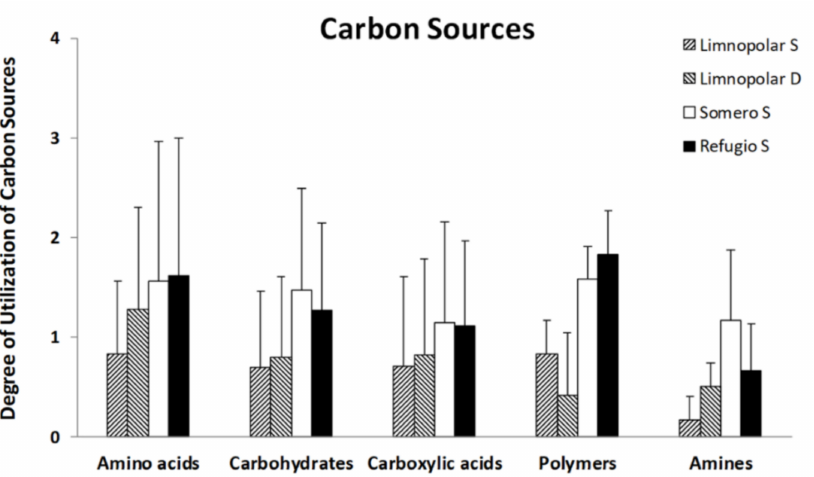
Figure 4. Average utilization values for the different carbon source groups (Biolog Ecoplates) by the microbial community of the Lake Limnopolar (S = surface and D = Deepest waters) and that of the surface water of the shallow lakes Somero and